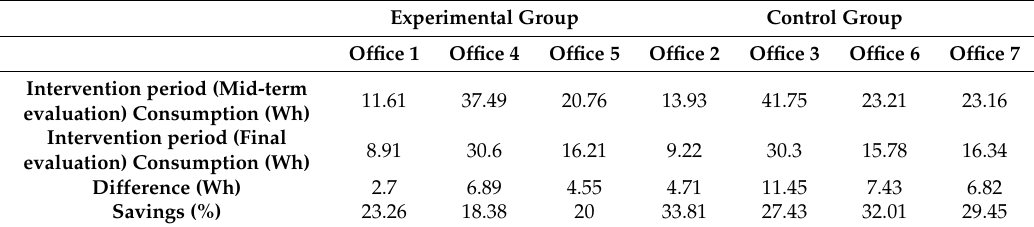
Table 6. Total consumption in Wh during the 22 days of Mid-term (Intervention period), during the 22 days of Final evaluation (Intervention period), difference in the consumption and savings between the two